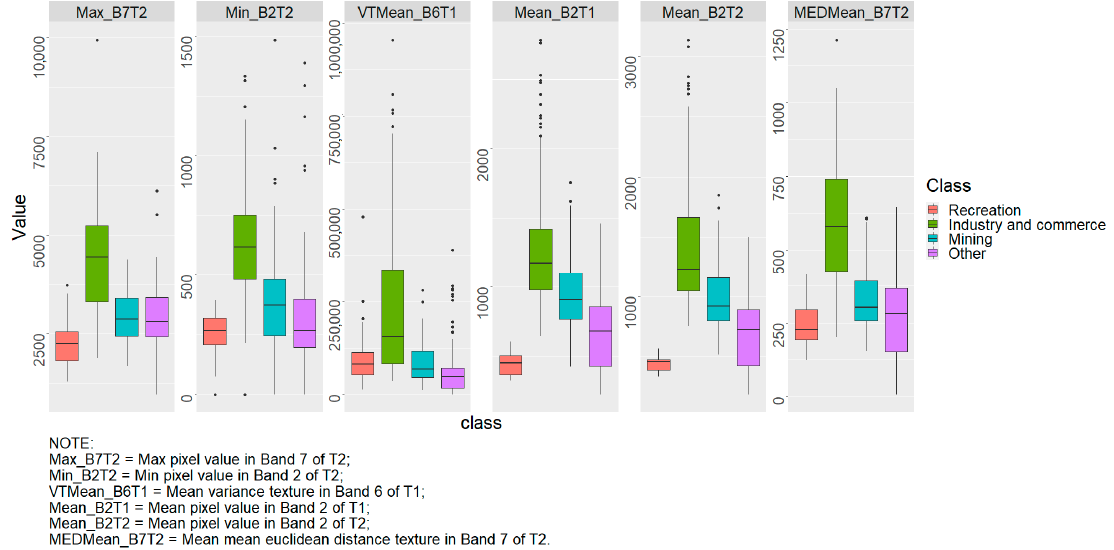
Figure 12. Value distribution of some derived attributes of